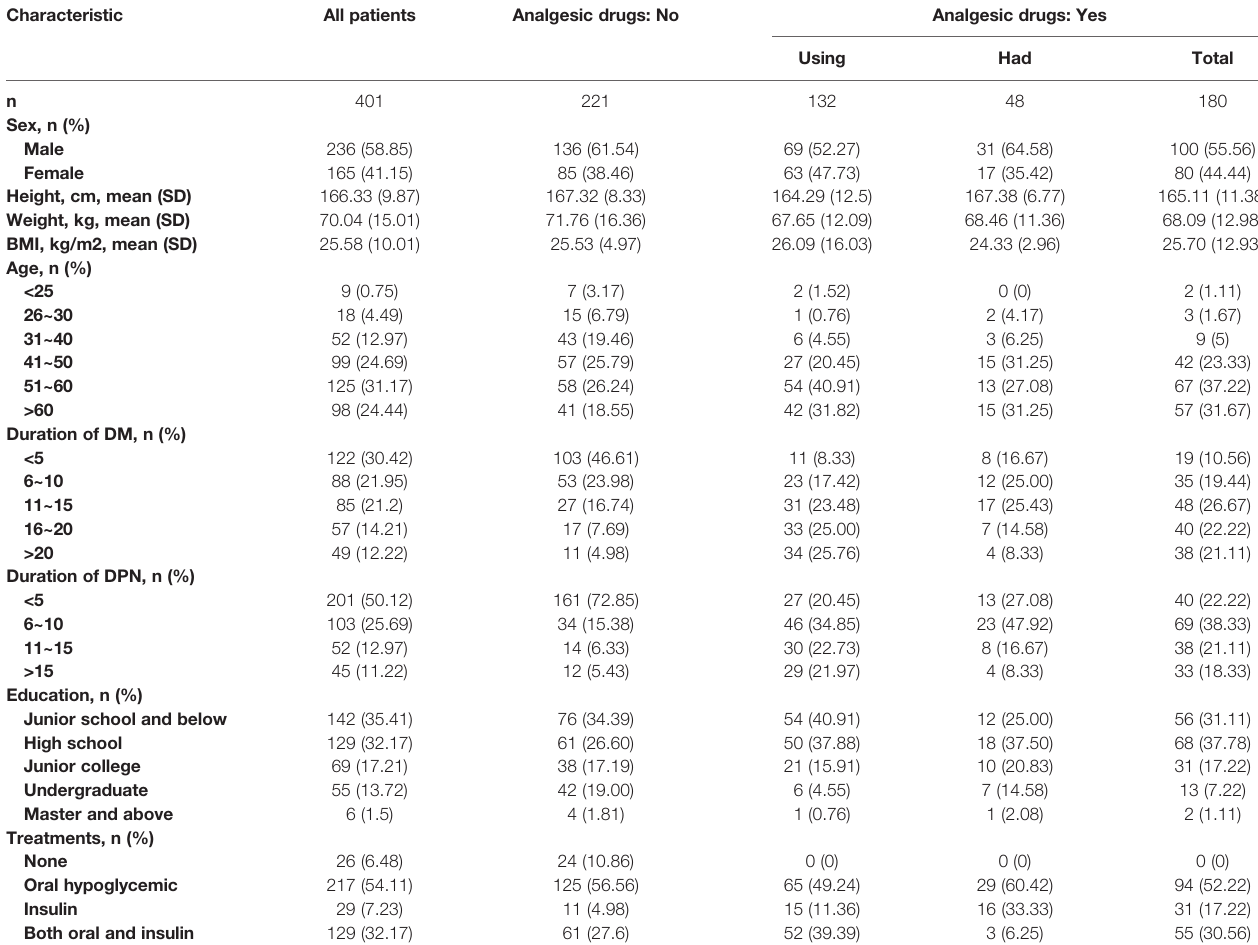
TABLE 1 | Clinical and sociodemographic characteristics of patients with diabetic peripheral neuropathy in China. Characteristic All patients Analgesic drugs: